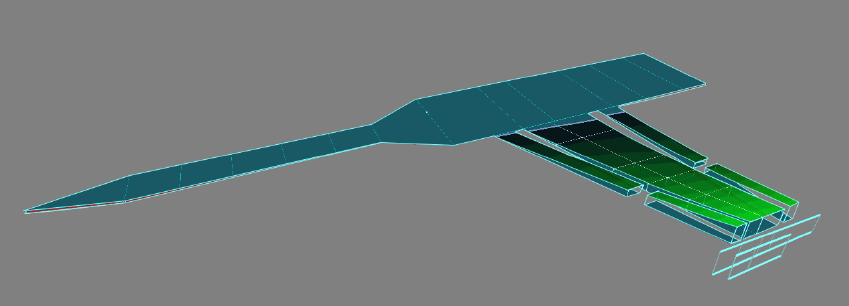
Figure A2. Structural deformation sample depiction from DePlotter. The figure shows a typical pure wing plunge mode, with a subtle pitch deformation in the